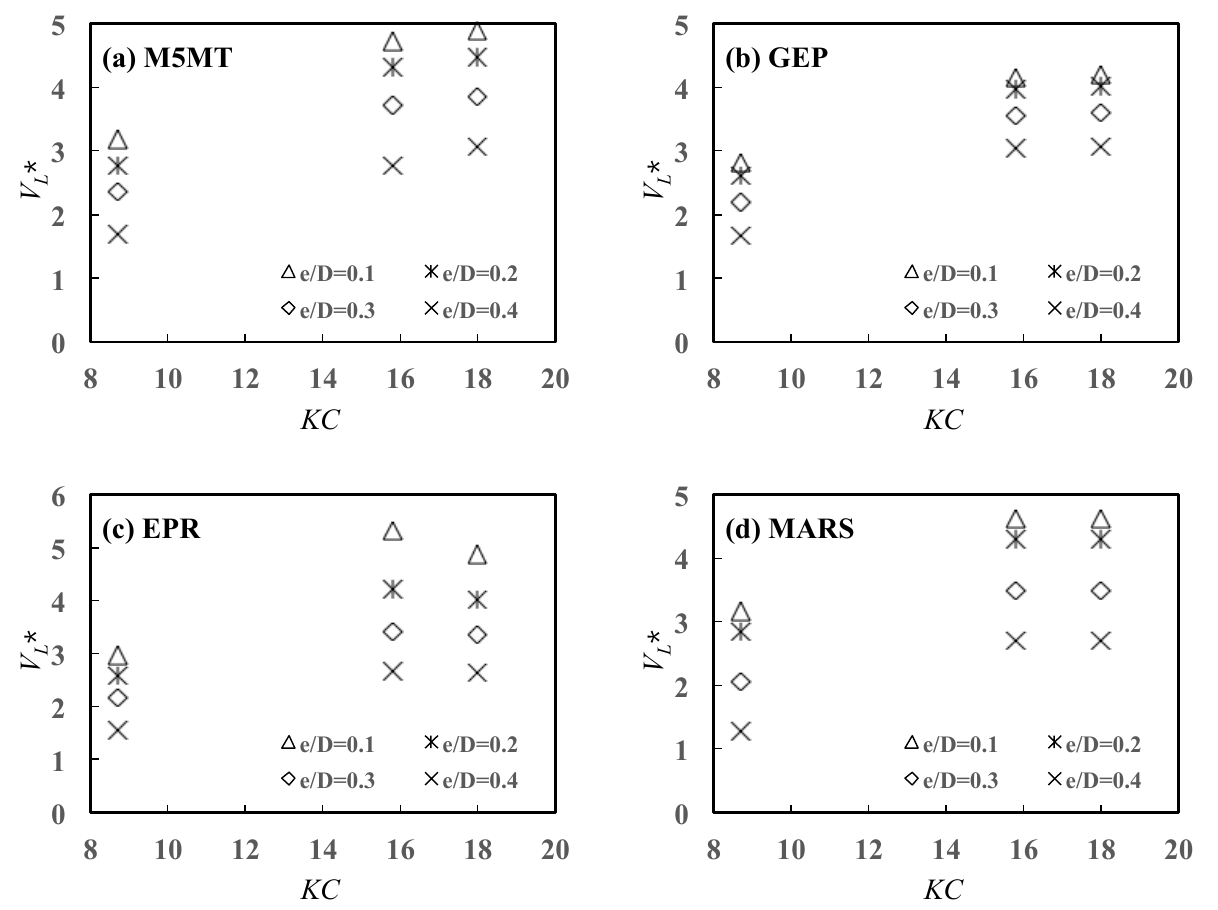
Figure 12. Variations of V ∗ against KC at e / D from 0.1 to 0.4 and α = 0 ◦ for: ( a ) M5MT, ( b ) GEP, ( c ) EPR, and ( d ) MARS. According to Table 7, the GEP model had the best performance (SSE = 0.0502) at KC = 8.7 while all other AI models indicated the most accurate prediction of V ∗ values for KC = 18. The EPR technique predicted variations of V ∗ versus e / D with highly satisfying performance at KC = 15.8 (SSE = 0.0494) and KC = 18 (SSE = 0.0272). Table 7 also indicates that M5MT (SSE = 0.0658), EPR (SSE = 0.0207), and GEP (SSE = 0.0188) had the most favorable performance at e / D = 0.3 while MARS (SSE = 0.00633) stood at the highest level of efficiency at e / D = 0.4. EPR model indicated more successful efficiency for e / D = 0.1 (SSE = 0.0720) and e / D = 0.2 (SSE = 0.0617) than the remaining AI models. What is more, GEP raised the most well-matched predictions for the variations of V ∗ versus KC with SSE = 0.0188 at e / D = 0.2, while EPR had the best performance (SSE = 0.00633) at e / D = 0.4.